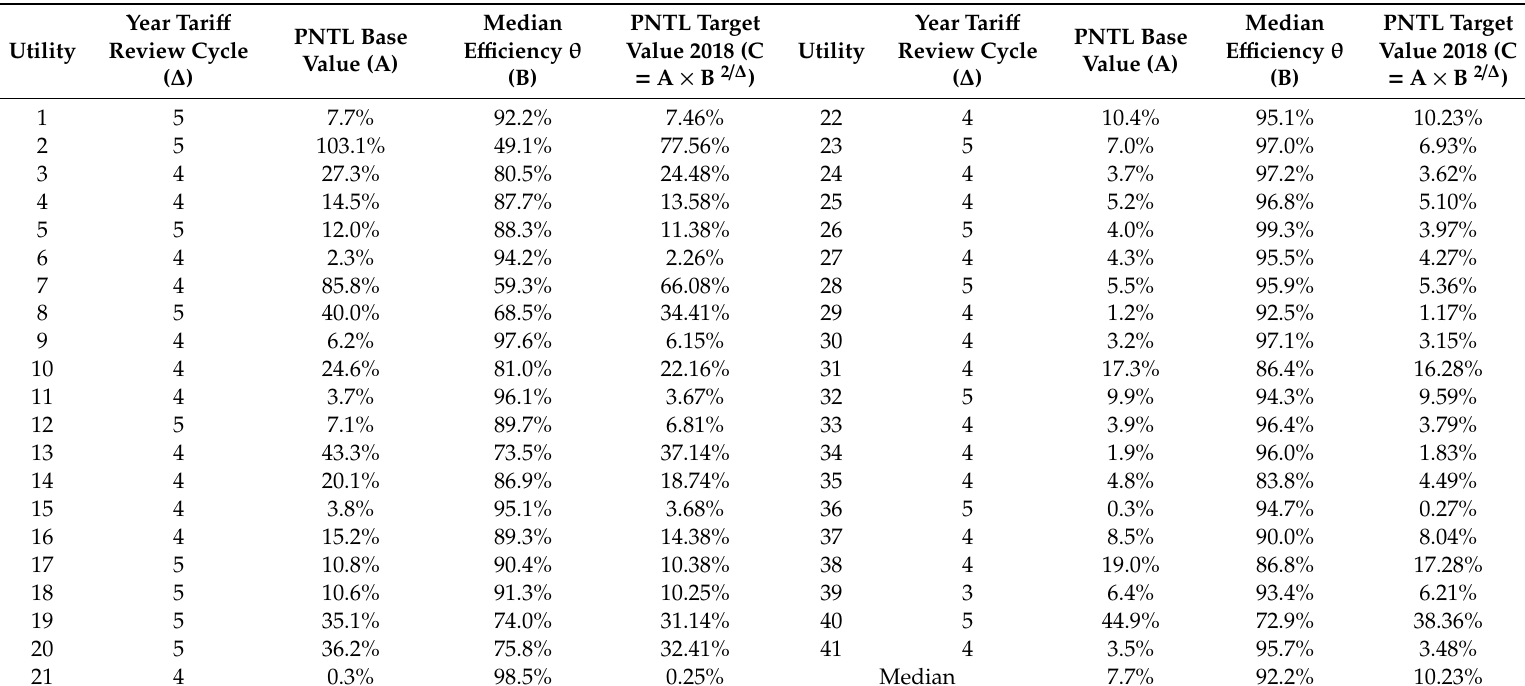
Table 3. Targets from SFA for